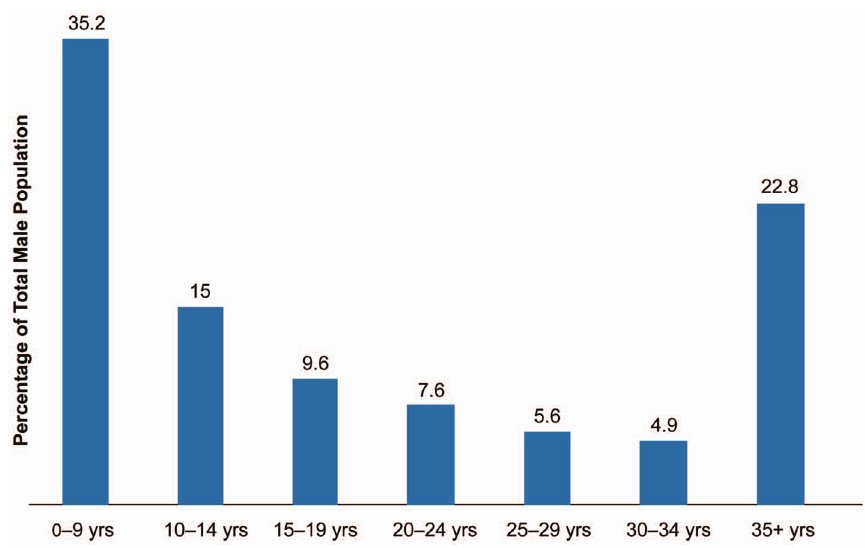
Figure 2. Percentage Age Distribution of Total Male Population, Zimbabwe.